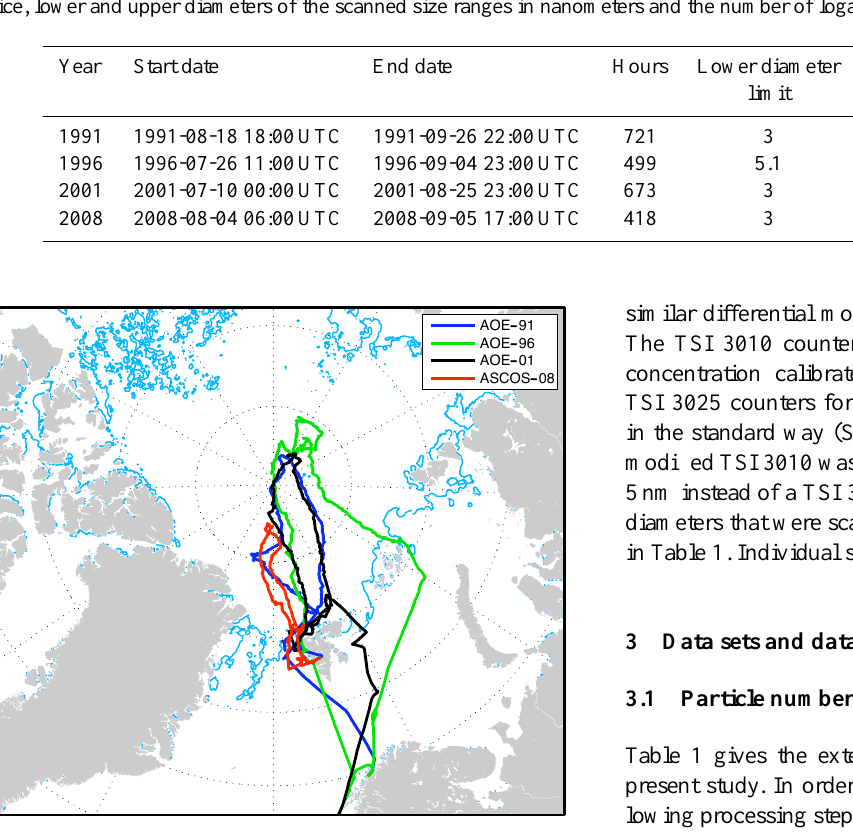
Fig. 1. Routes of the Oden Expeditions in 1991, 1996, 2001, and 2008. The blue line delineates the ice edge on 12 August